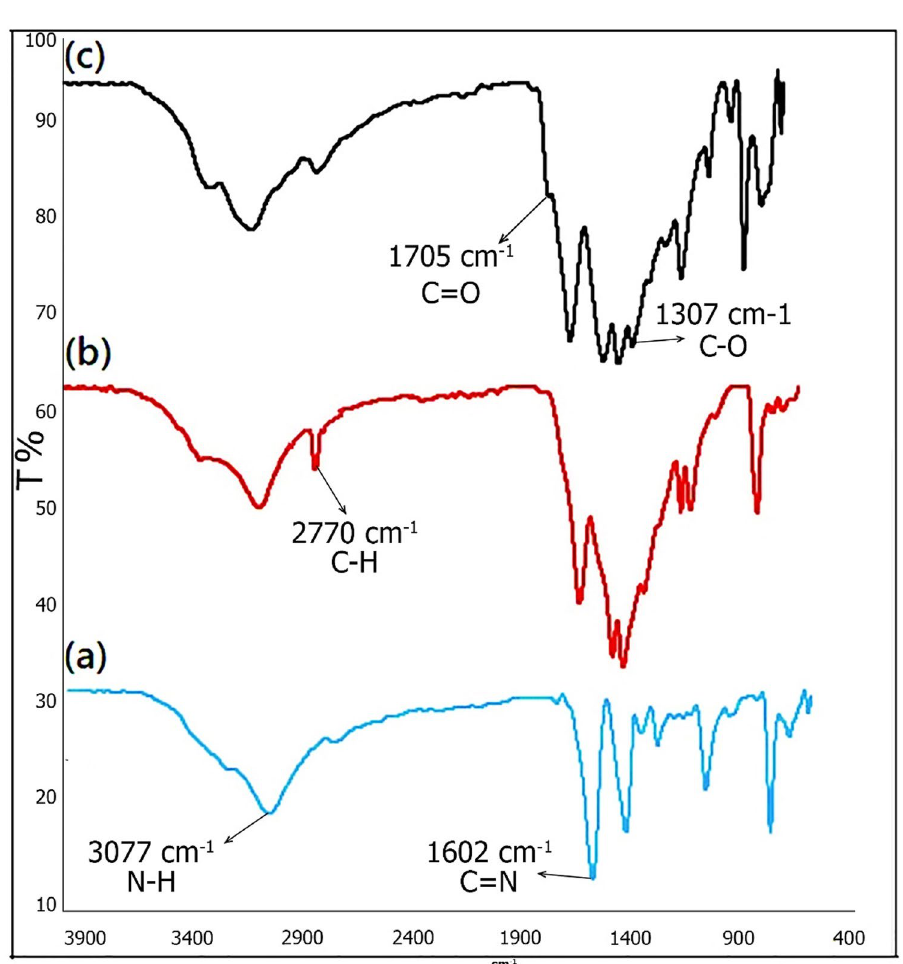
Figure 3. FT-IR spectra of ( a ) nanosheets g-C 3 N 4 , ( b ) modified g-C 3 N 4 , ( c ) g-C 3 N 4